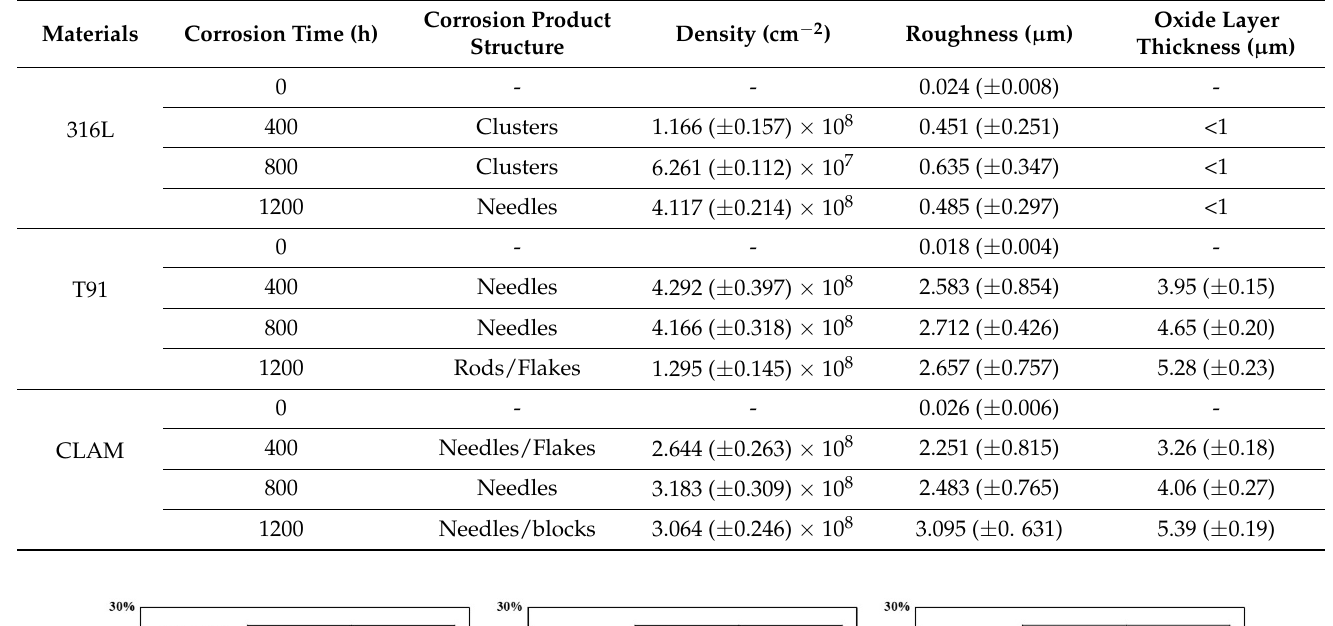
Table 2. Statistical density, structure, roughness, and oxide layer thickness of the corroded sample surface.